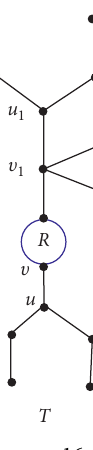
Figure 16: The tree T .